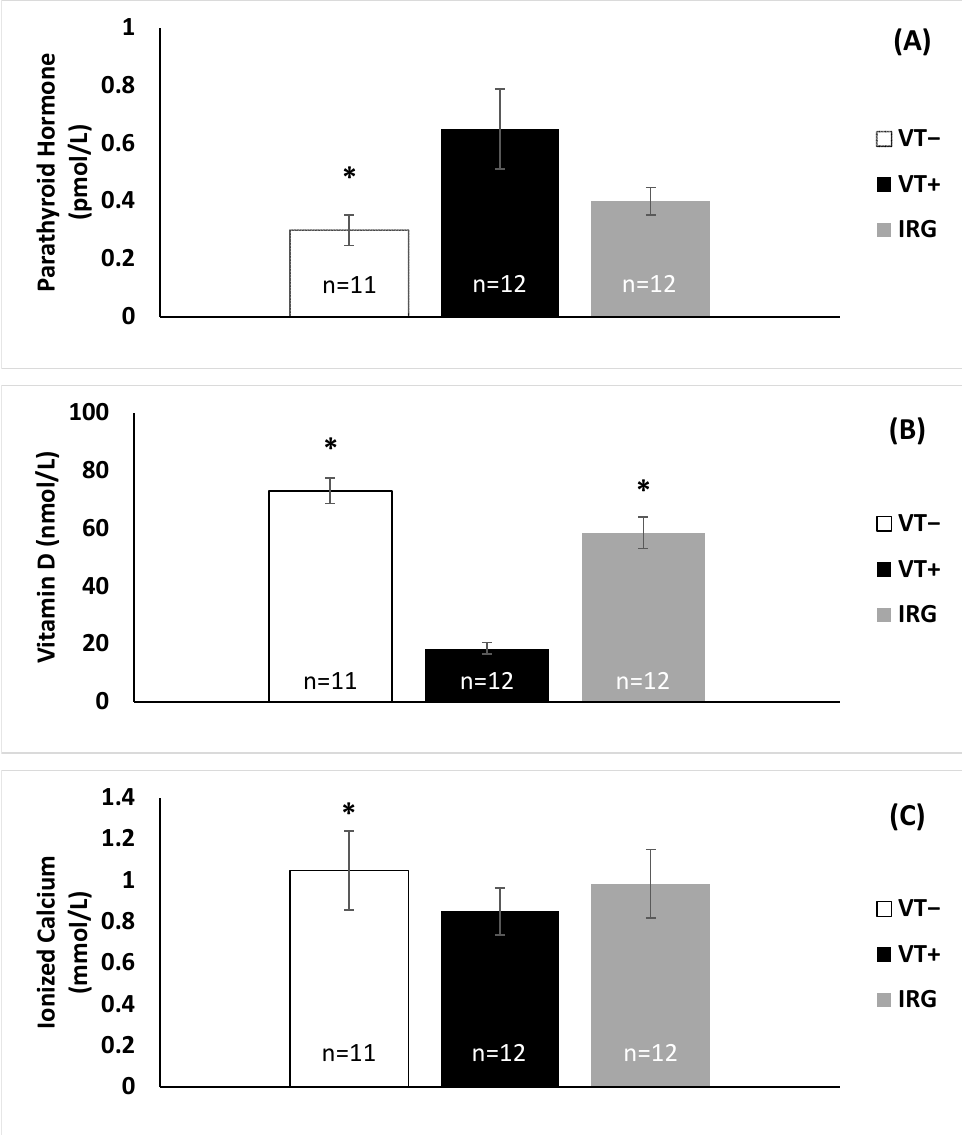
Figure 3. Parathyroid hormone ( A ), vitamin D ( B ), and ionized calcium ( C ) levels on intake for turtles taken into rehabilitation with (VT+) and without (VT − ) papilloma tumors and in healthy wild-caught (IRG) individuals. * Indicates groups that were significantly different from the VT+ turtles ( p < 0.05). Error bars are one standard error from the median for ( A , B ). Error bars were one standard deviation from the mean for ( C ). Table 2. Number of individuals sampled in each treatment group at various time points while re- siding at GLNC. Time points were grouped into 30-day periods. Some individuals were sampled multiple times depending on the duration they remained at GLNC. Some VT+ individuals died or were euthanized shortly after intake and so were sampled only once.